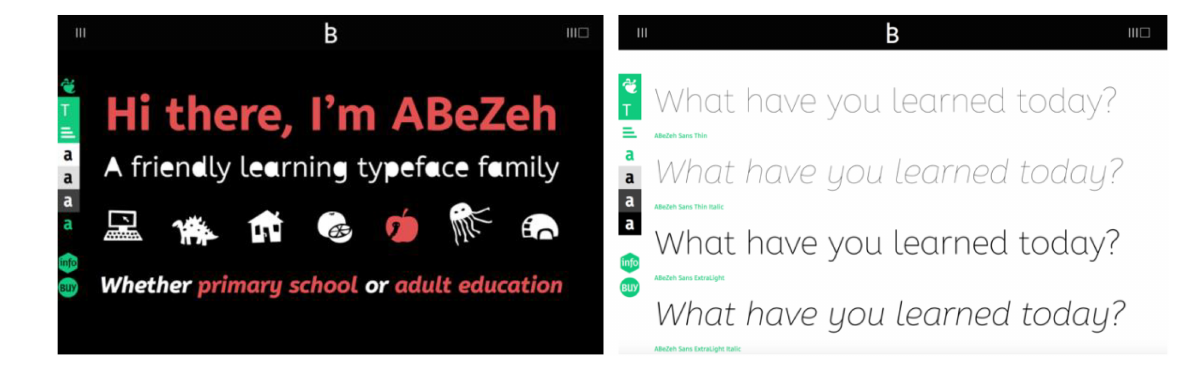
plays and shows a child’s hand writing the letter using the proper stroke order while a perfect mark of the letter appears underneath the actor’s hand. The goal is for the child to model the trace hint animation and successfully write the letter.